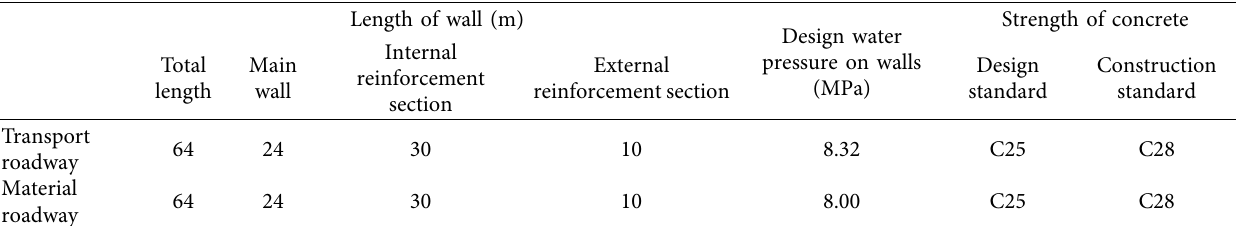
Figure 4: Longitudinal profile and cross section of water retention bulkhead in roadway. Table 1: Design parameters of water retention